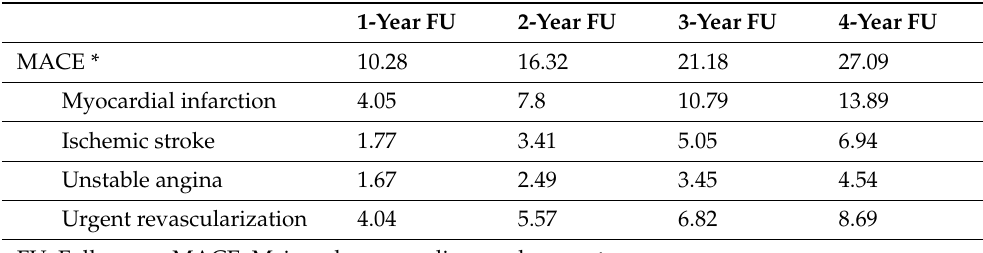
Table 2. Cumulative incidence of MACE.